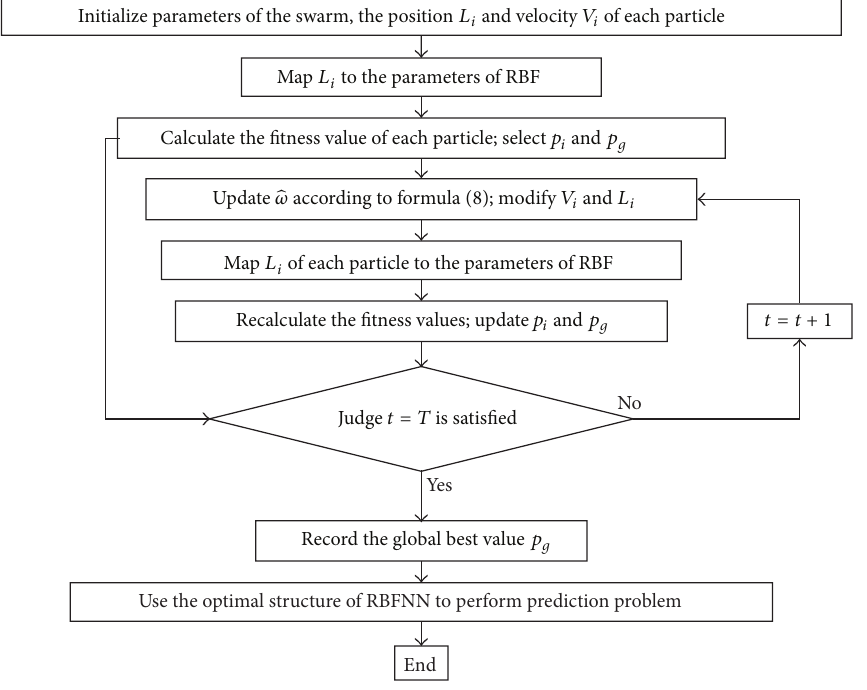
Figure 2: The flowchart of EDIW-PSO-RBF learning algorithm.